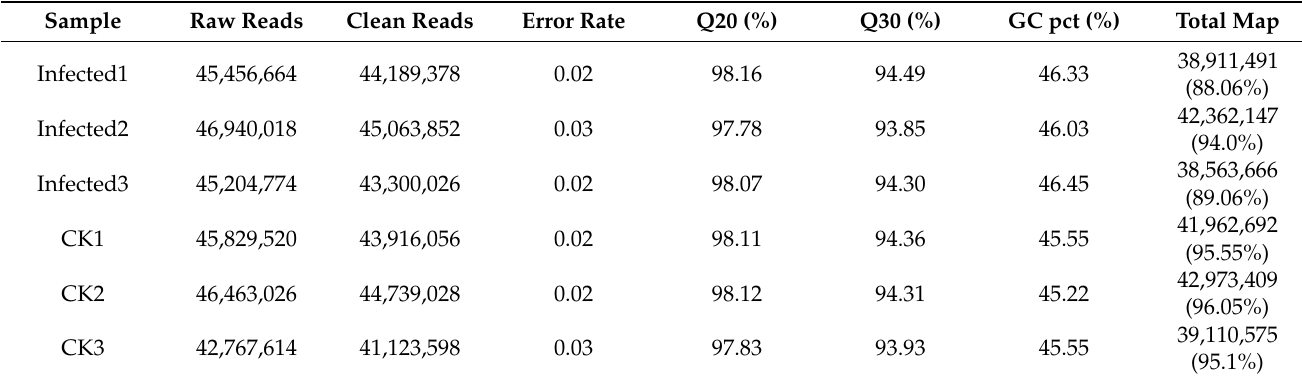
Table 1. Sequencing data for the six